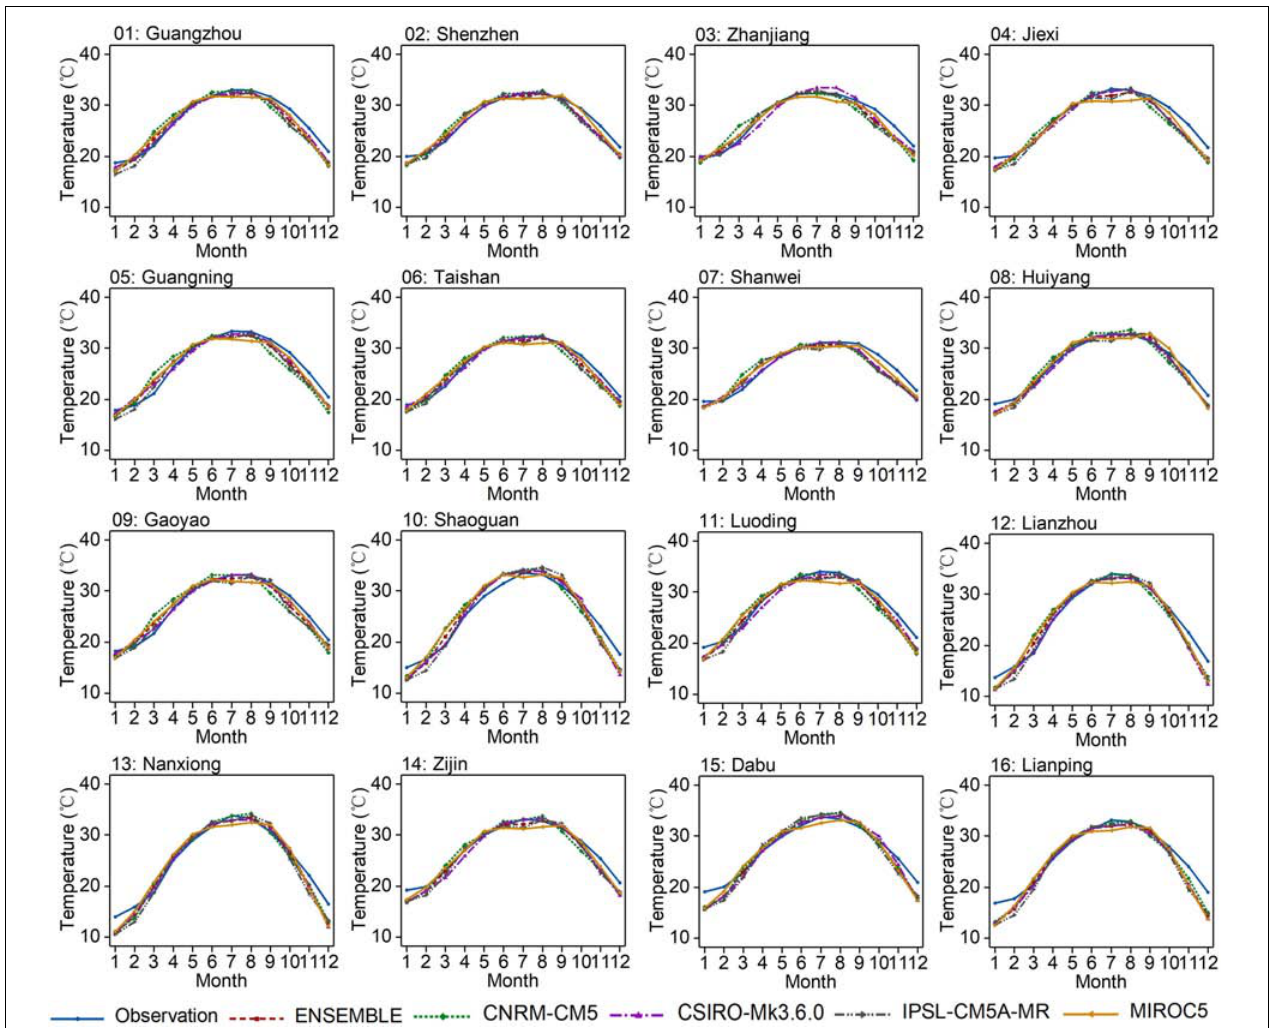
FIGURE 5 | Monthly variations of the observed Tmax and downscaled values for GCMs and their ensemble at the 16 selected weather stations,